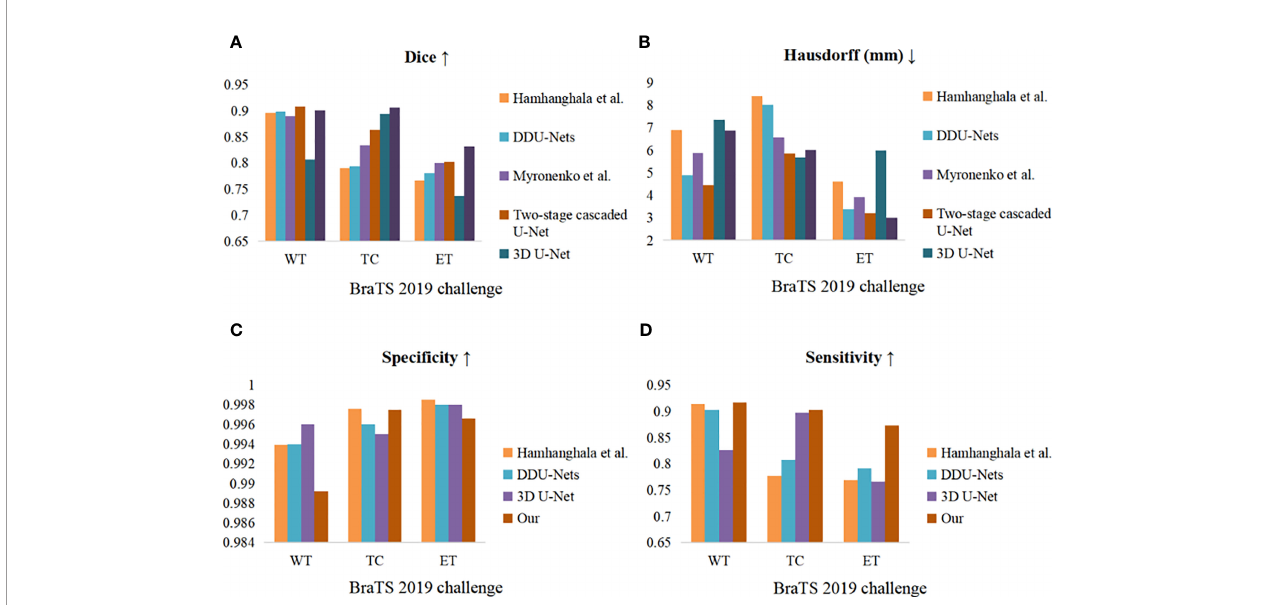
FIGURE 10 | Comparative histograms of evaluation indicators for four methods on the BraTS 2019 validation set. (A – D) Dice, Hausdorff (mm), speci fi city, and sensitivity. The colors correspond to the